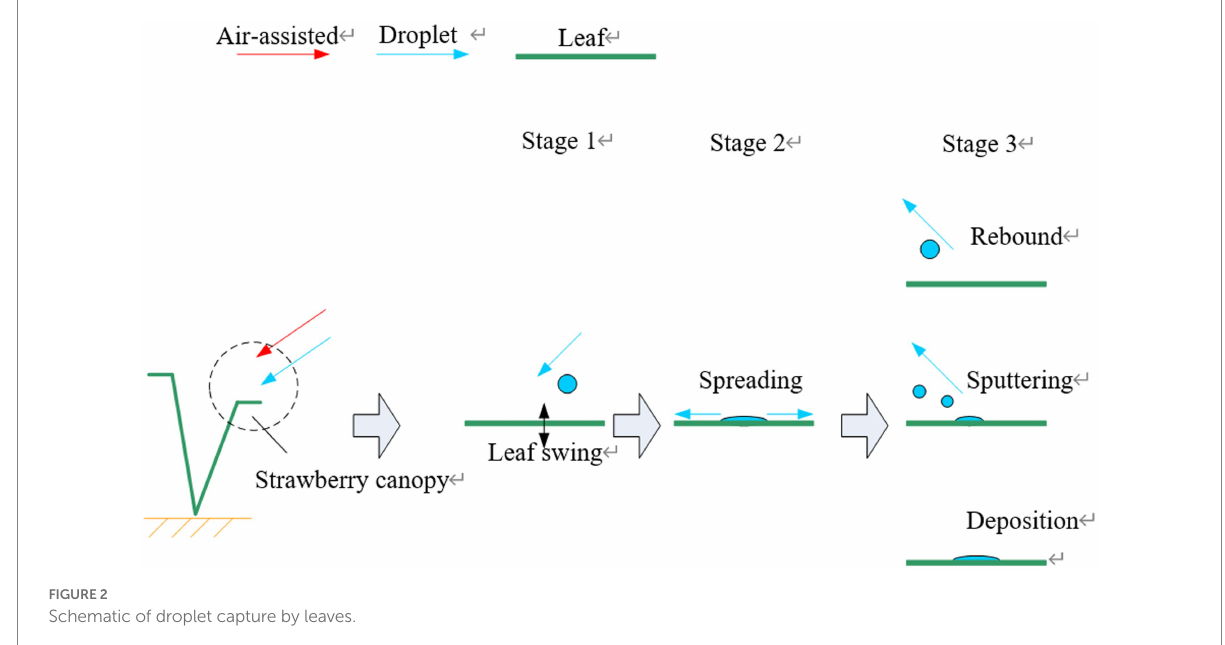
FIGURE 2 Schematic of droplet capture by leaves.